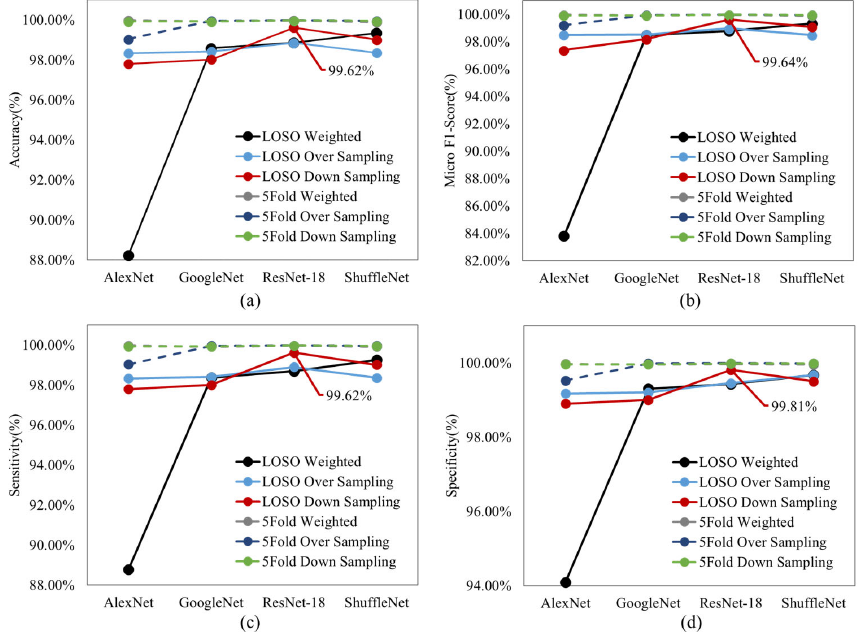
Figure 4. ( a ) Accuracy, ( b ) micro F1 score, ( c ) sensitivity, and ( d ) specificity of all four 2D pre-trained models with both LOSO and 5–fold validations.